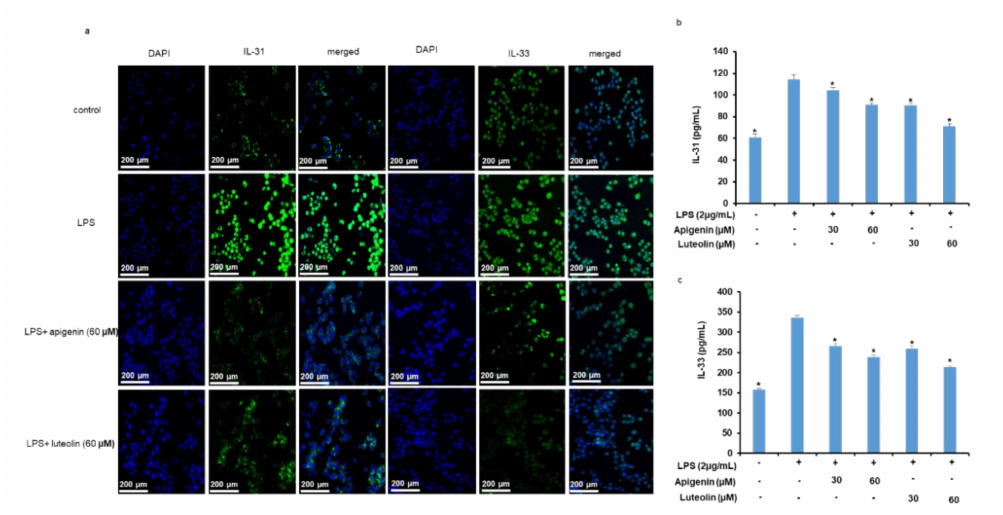
Figure 4. Apigenin and luteolin inhibit LPS-induced expression of IL-31 and IL-33 protein expressions and their secretion out of microglia cells. Microglia cells (5 × 10 5 cells / mL) were cultured and pre-treated with apigenin or luteolin and then stimulated with LPS for 12 h ( a ) or 24 h ( b,c ). The expression of IL-31 and IL-33 in the microglia was investigated by immunofluorescence at × 10 magnification ( a ). The Cell media were collected for IL-31 and IL-33 measurements by ELISA assay kits ( b,c ). Where applicable, the results are presented as mean ± SD ( n = 3). The asterisk (*) indicates a significant di ff erence at p < 0.05 compared to the LPS-only treated cells for bars with the same